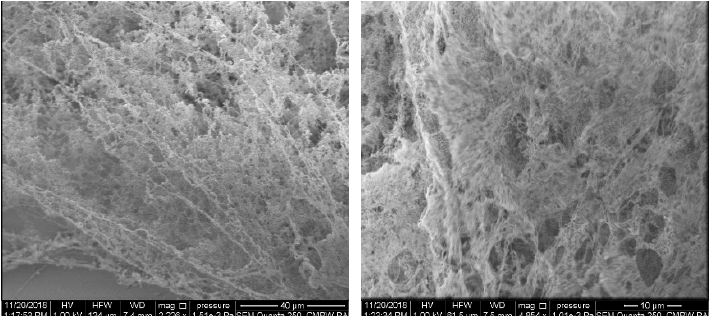
Figure 5. Scanning electron microscopy (SEM) micrographs of P(iPrOx-MOx)1 annealed in water for 12 h at the polymer-rich phase state.